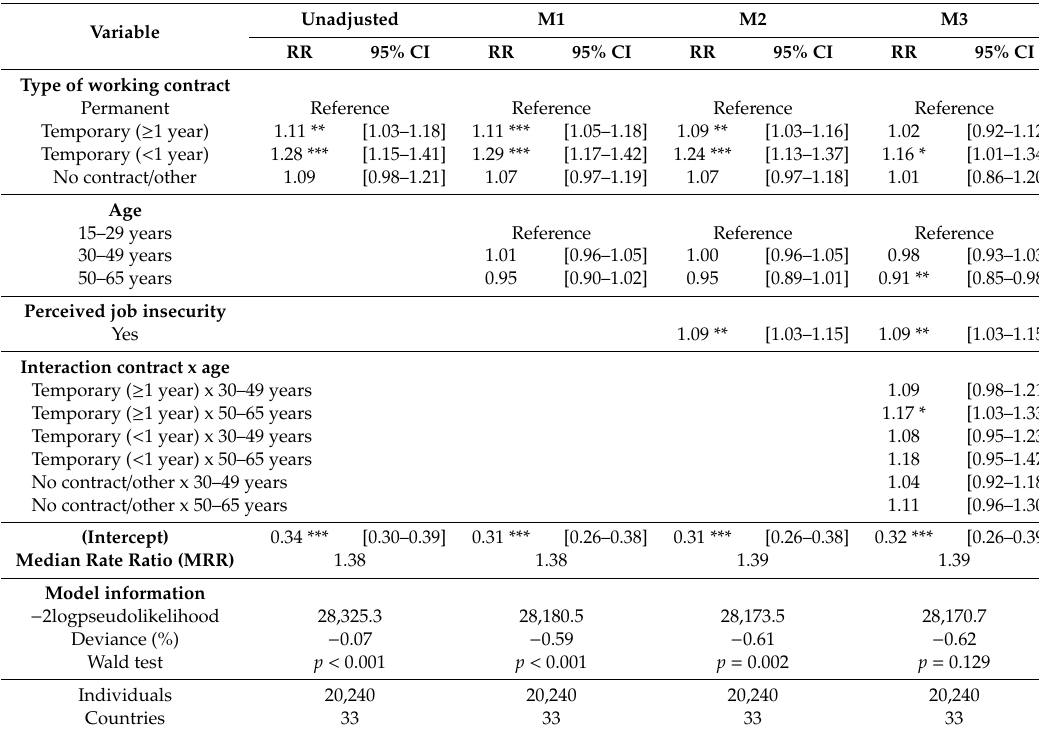
Table 4. Multilevel Poisson regression: Rate ratios (RR) of presenteeism propensity by di ff erent sets of covariates. Unadjusted M1 M2 M3 Variable RR 95% CI RR 95% CI RR 95% CI RR 95% CI